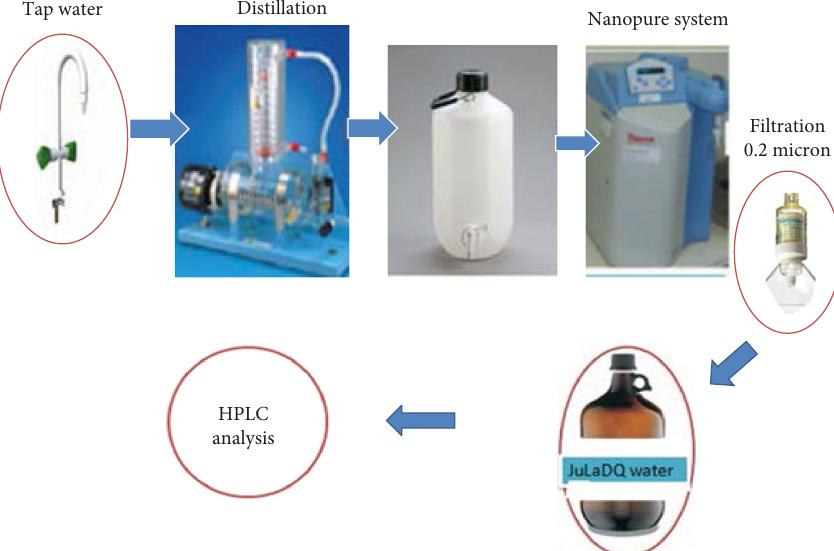
Figure 3: Customized JuLaDQ water purification